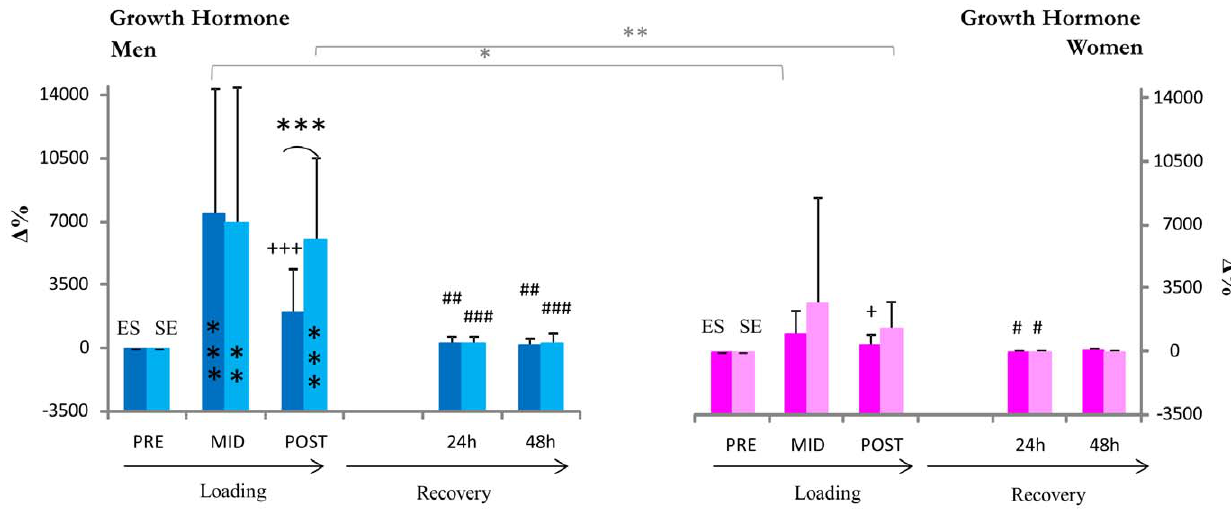
Figure 5. Growth hormone. **,*** inside column=significant change (p , 0.01, p , 0.001) from pre in absolute GH concentrations, +++ =significant change (p , 0.001) in absolute GH from mid, ## , ### =significant change (p , 0.01, p , 0.001) in absolute GH from post, *[, **[=significant difference (p , 0.05, p , 0.01) between changes in GH concentrations from pre in men and women, ***(=p , 0.001 significant differences between relative changes from pre in ES and SE loadings.